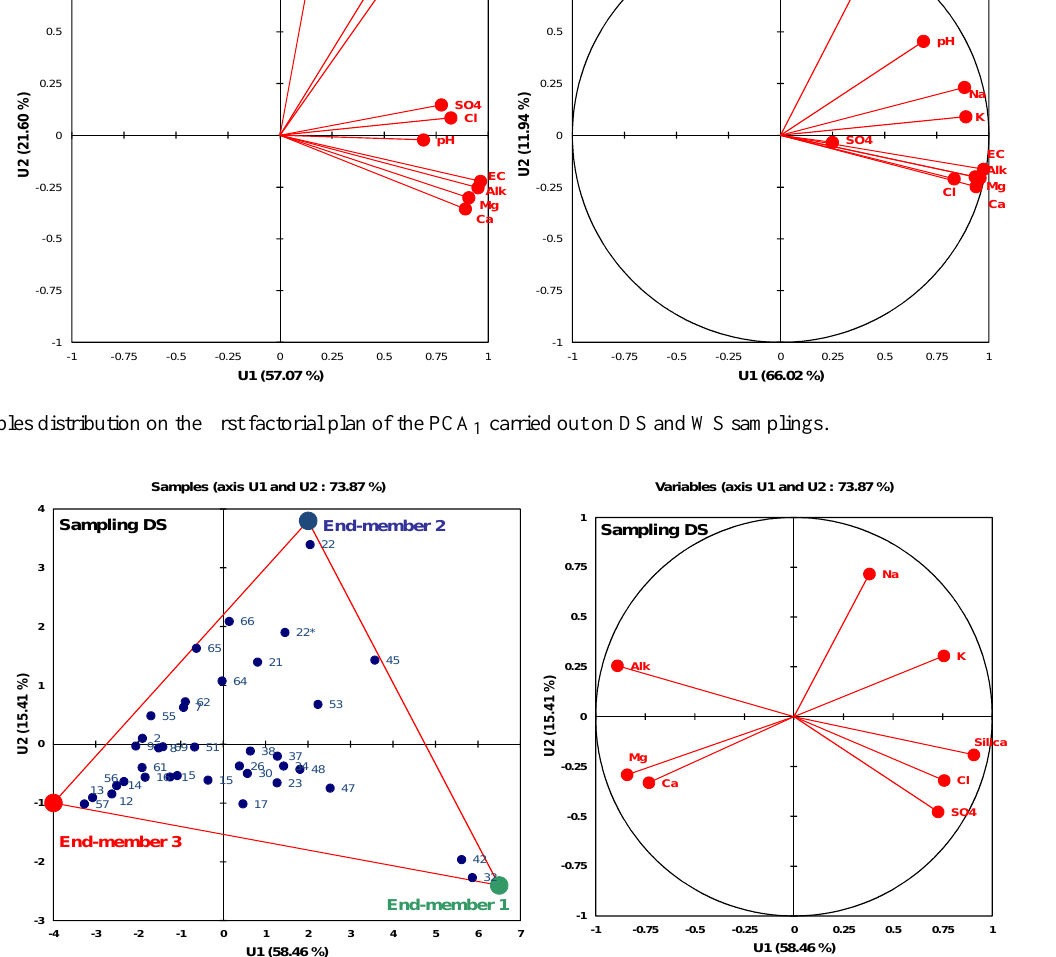
end-members 1 and 2 changed mainly under the influence of sulphate concentrations between DS and